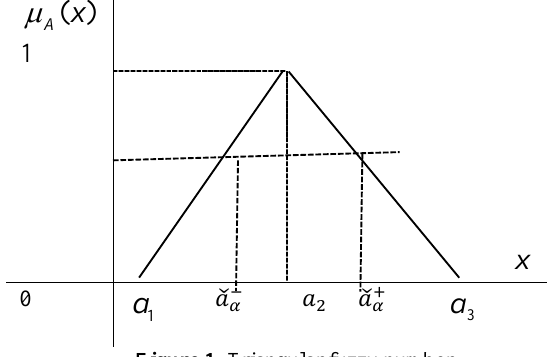
Figure 1. Triangular fuzzy